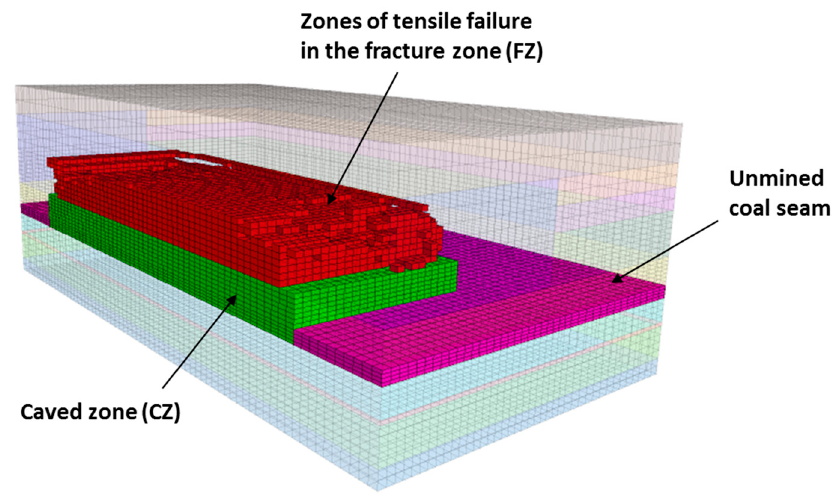
Figure 6. Distribution of tensile failure zones in the fractured zone.